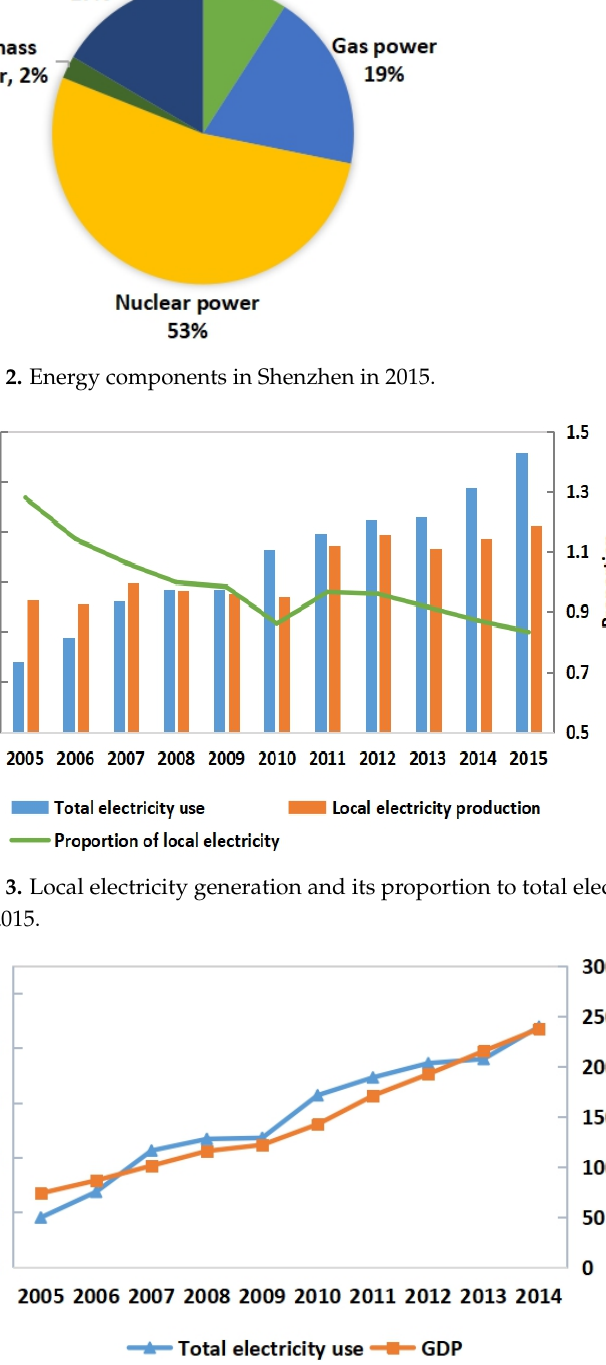
Figure 2. Energy components in Shenzhen in 2015.